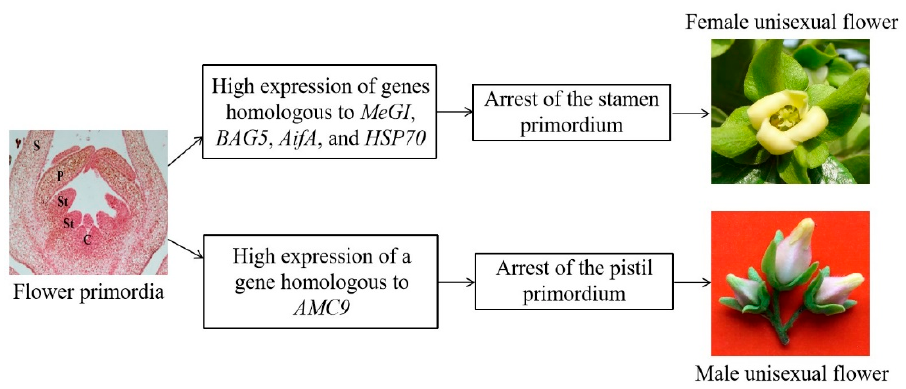
Figure 12. Putative regulatory pathways for PCD in female / male organ. (C = carpel; P = petal; S = sepal; St = stamen).